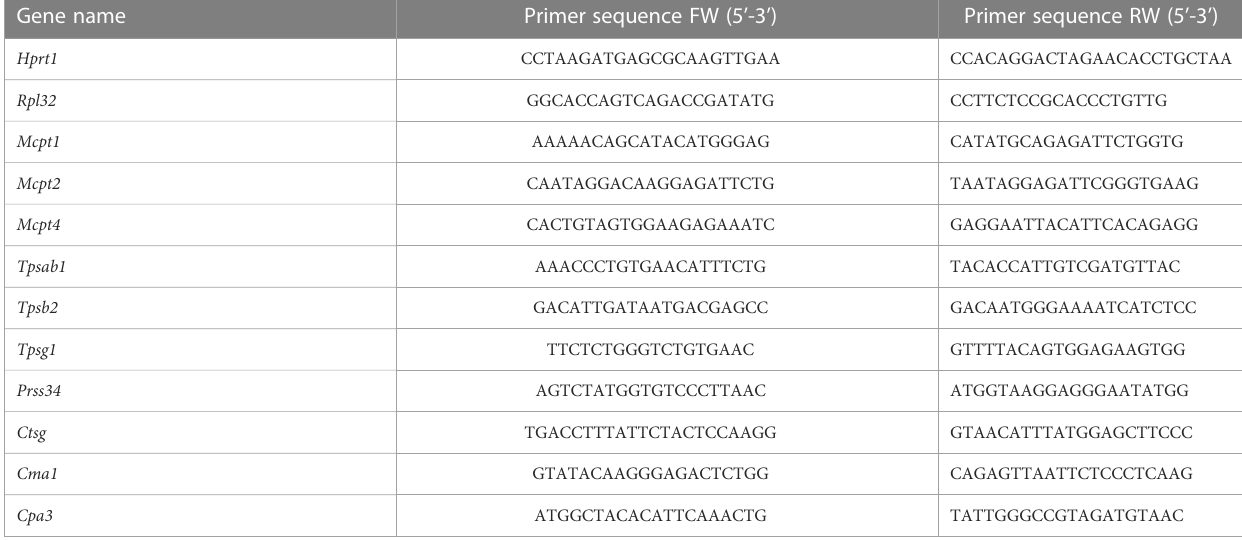
TABLE 2 List of primers used in the